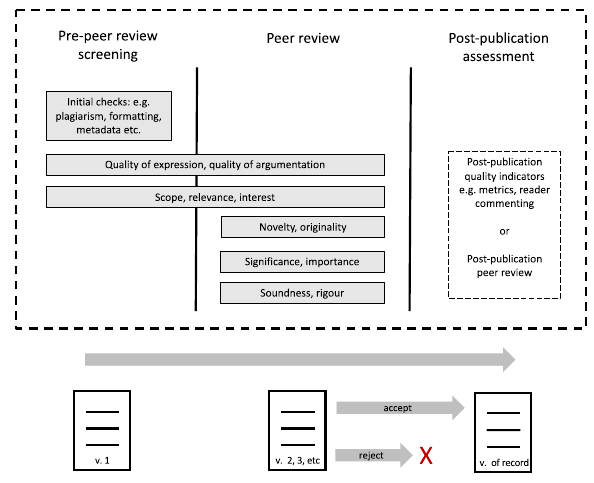
Fig. 1 Dimensions of the peer review process. Quality metrics and their relevance along the phases of the peer review